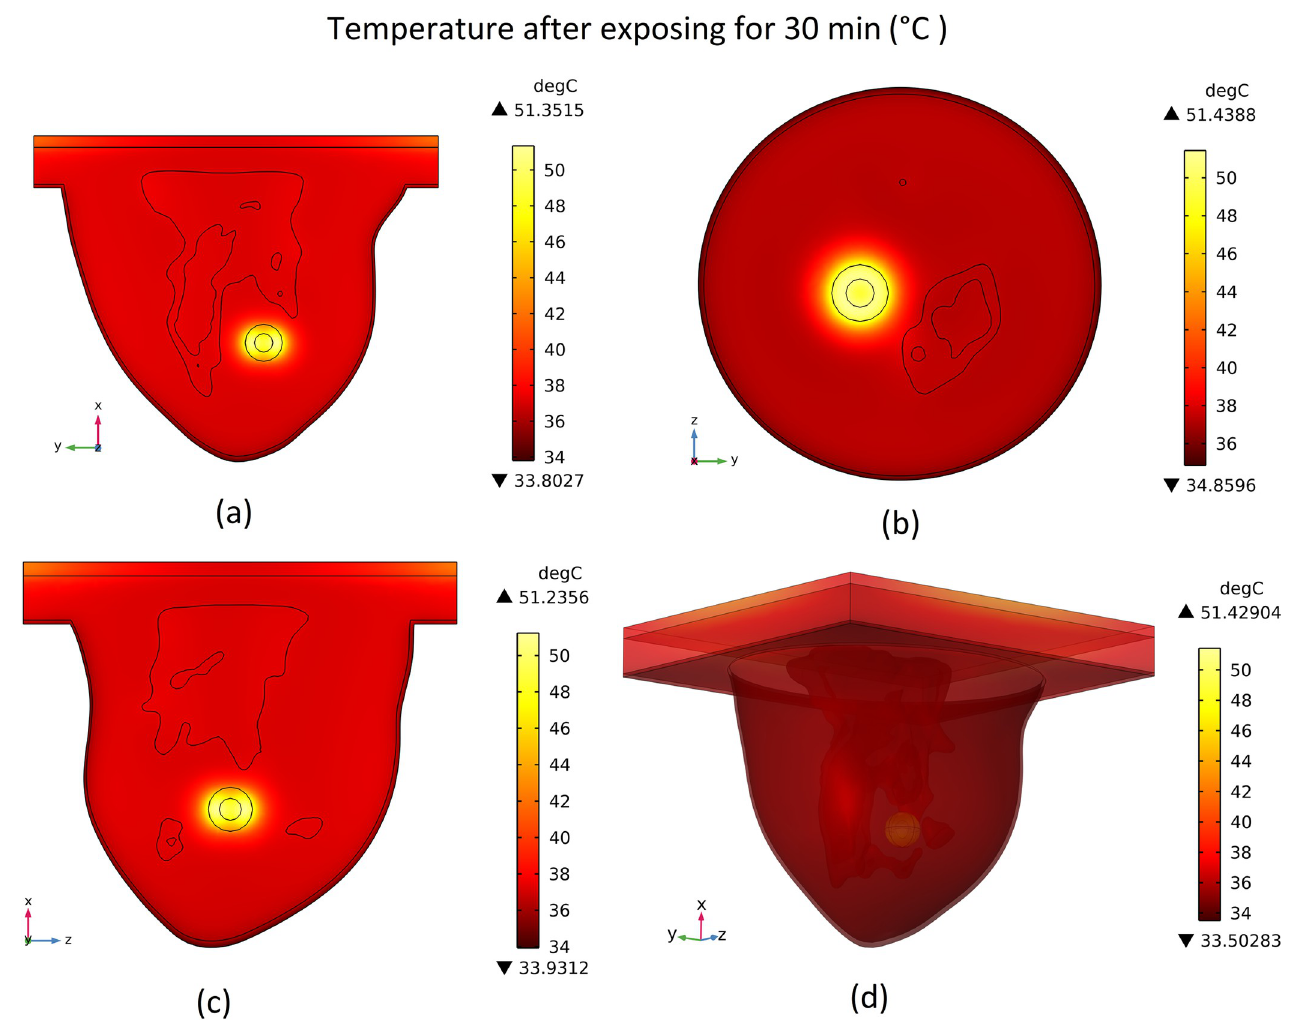
Fig 15. Distribution of temperature after 30-min-exposure to the magnetic field, (a) cut surface 1, (b) cut surface 2, (c) cut surface 3, (d) 3D